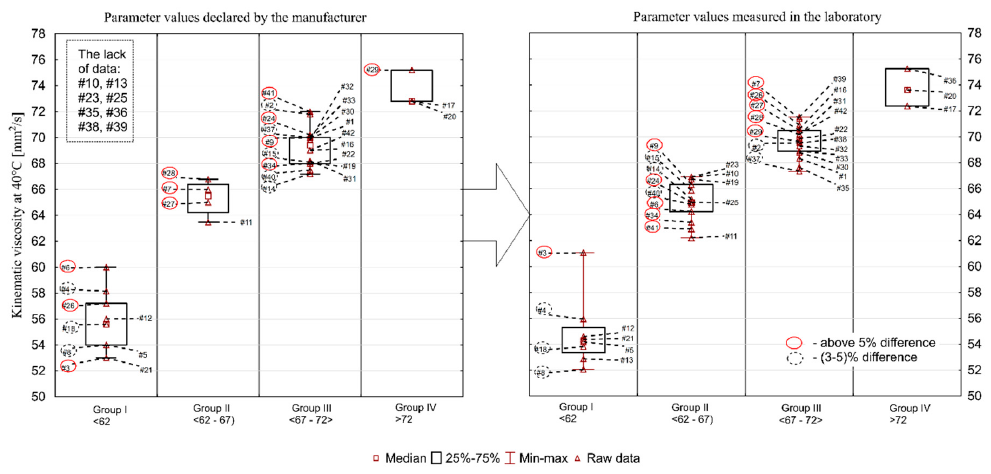
◦ C. Energies 2020 , 13 , x FOR PEER REVIEW